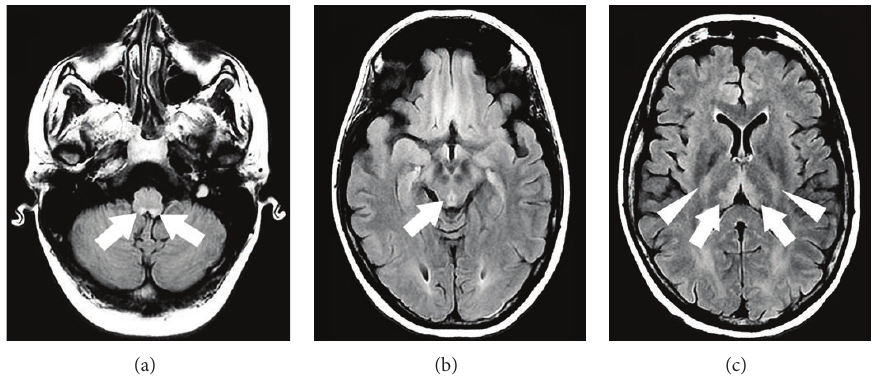
Figure 11: A patient with Wernicke syndrome showing FLAIR hyperintensities in the hypoglossal nuclei (a), the periaqueductal gray matter and mesencephalic tectum (b), the medial part of the thalami (arrows, c), and the pyramidal tracts (arrowheads,